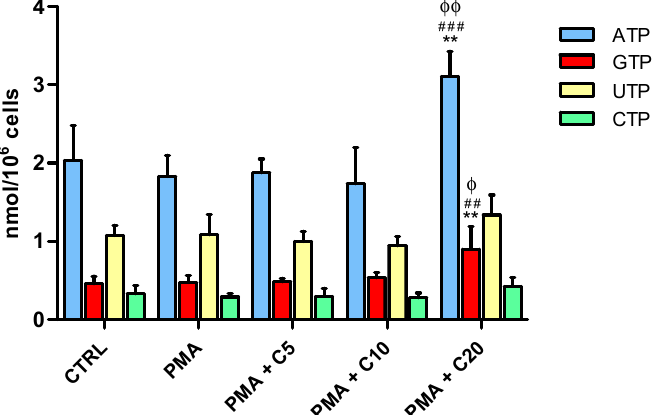
Figure 2. Changes in nucleoside triphosphate concentrations (ATP, GTP, UTP, and CTP), expressed as nmol / million cells, in resting (control) macrophages and in macrophages stimulated with PMA and SOD inhibitors, in absence or presence of increasing concentrations (5, 10, or 20) of carnosine. Values are means ± SD of four independent experiments. ** p < 0.01 vs. CTRL; ## p < 0.01 vs. PMA; ### p < 0.001 vs. PMA; ϕ p < 0.05 vs. PMA + C5 and PMA + C10; ϕϕ p < 0.01 vs. PMA + C5 and PMA + C10.